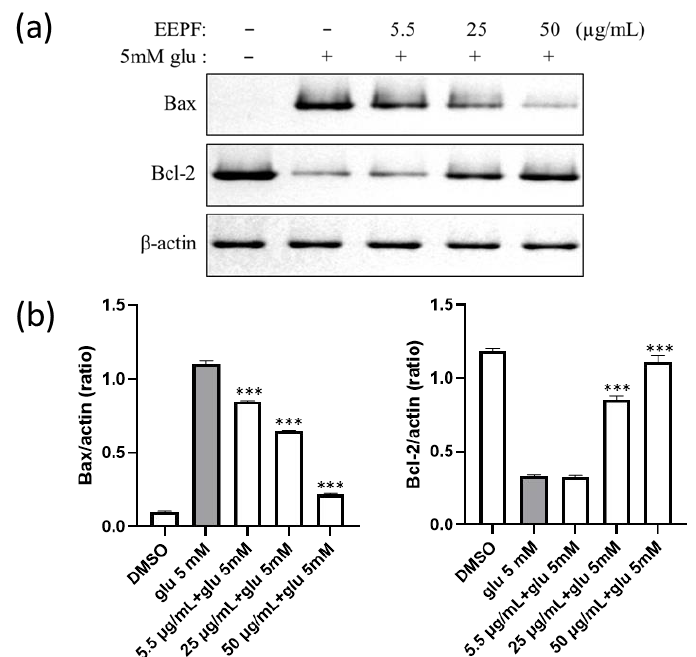
Figure 6. The 75% EEPF regulated apoptotic-related proteins. ( a ) Protein expression levels of Bax and Bcl-2. The 75% EEPF co-treatment decreased Bax protein and increased the Bcl-2 proteins levels and prevented the cell death. ( b ) Bar graph of the intensity of immunoblot bands visualized using the image J software. Data presented as the mean ± standard deviation (SD) of two independent experiments. *** p < 0.001 vs. the glu 5 mM group.